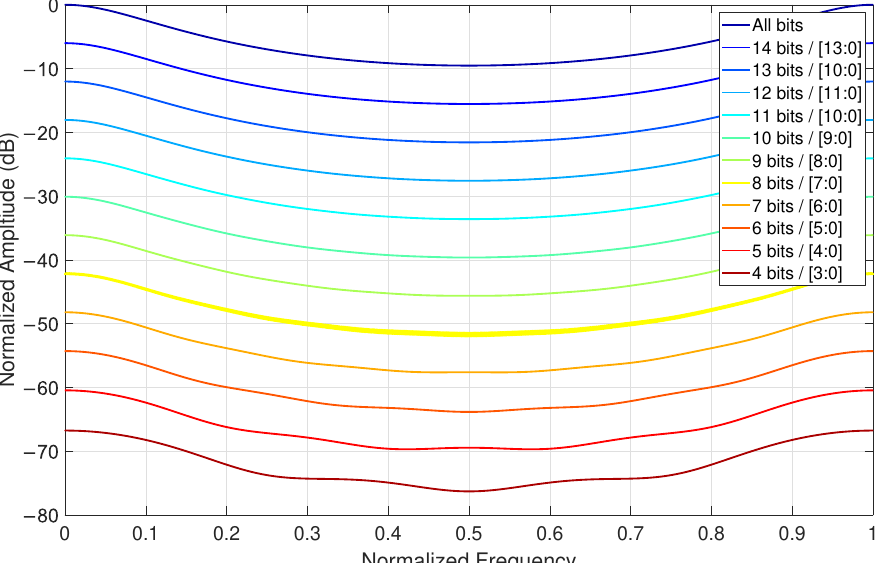
Figure 4. The magnitude of Fourier transform of 15 bit maximum-length LFSR generator output signal (DC value